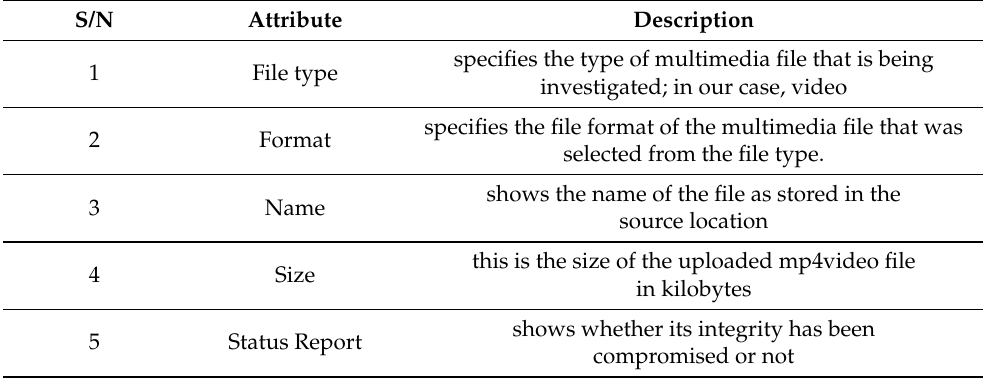
Figure 8. Result of analysis of MP4 file using the PBF tool. Table 5. Description of the interpretation of the output of the